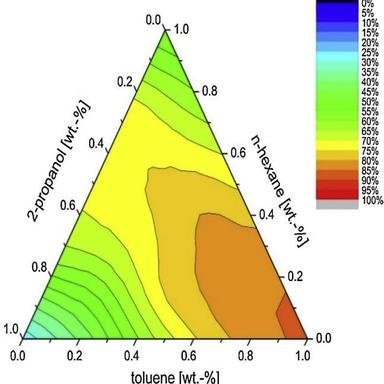
MRM of StarmemTM 122 membrane in ternary mixture with n-hexadecane.